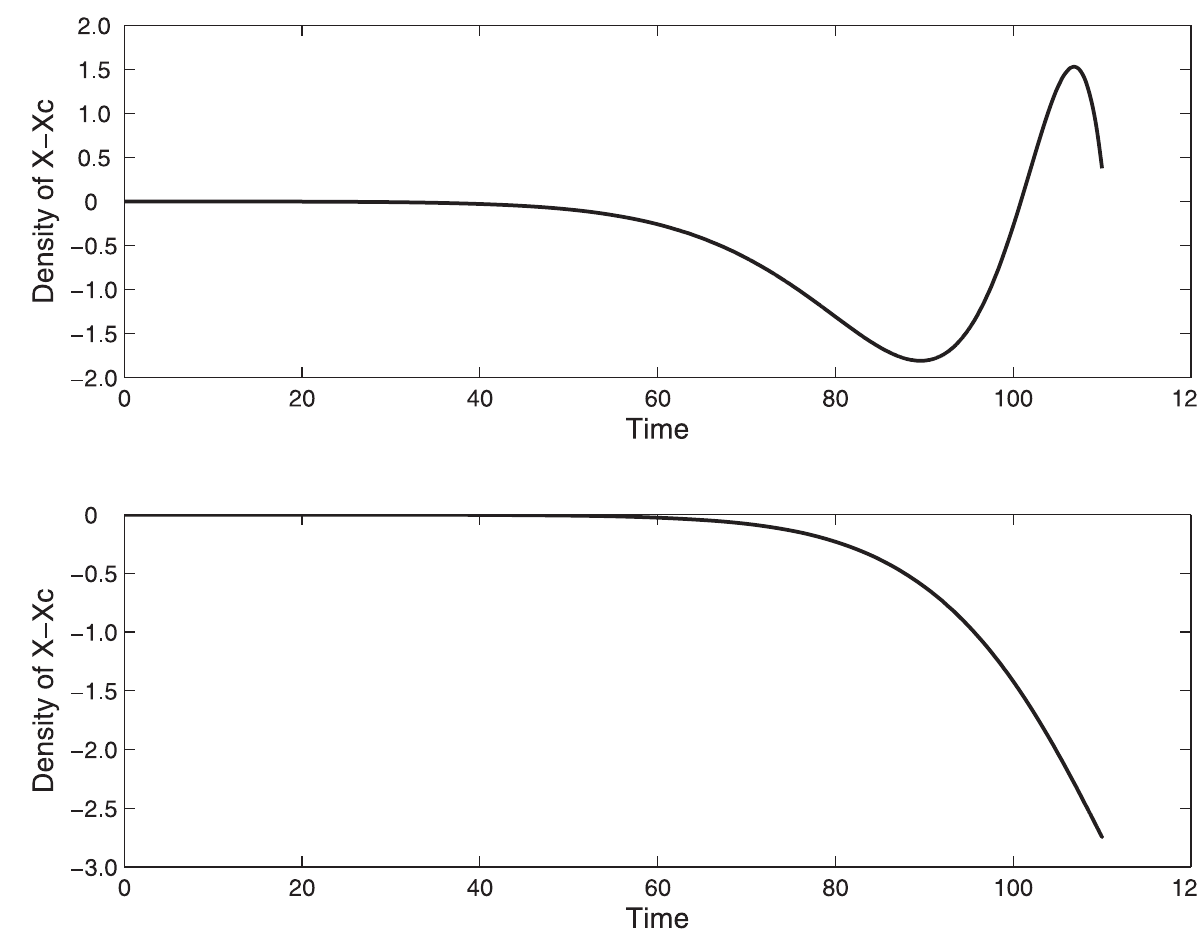
~ 1 . A . cross-feeding is favoured for initial conditions e c